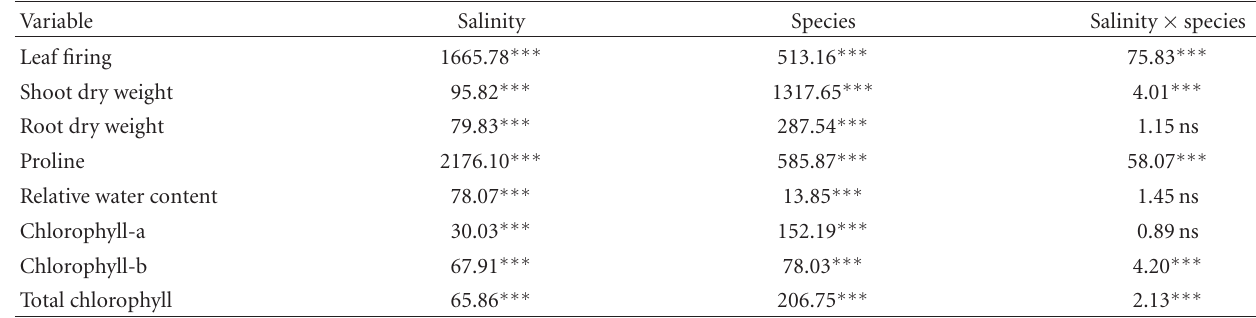
Table 2: Main e ff ect and interaction e ff ect on di ff erent variables by salinity and species.